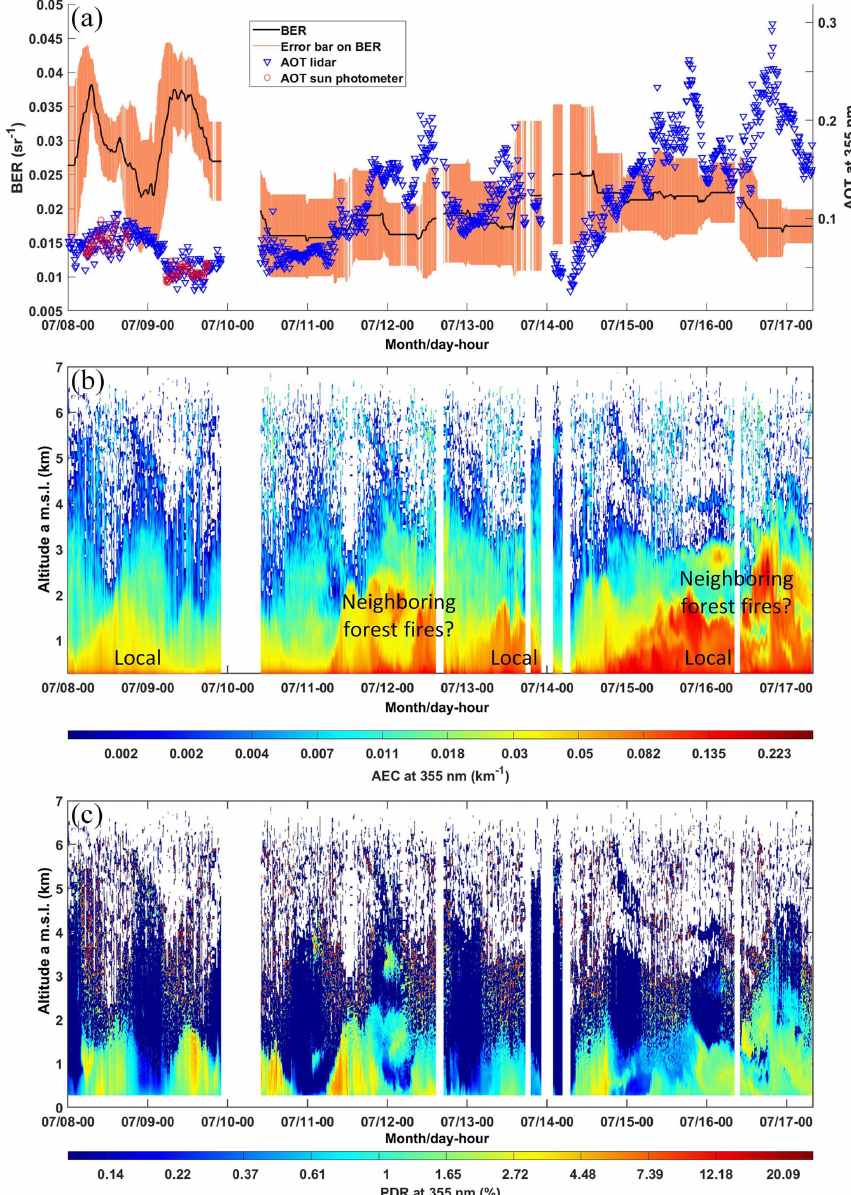
Figure 3. Same as Fig. 2 for the period between 8 and 17